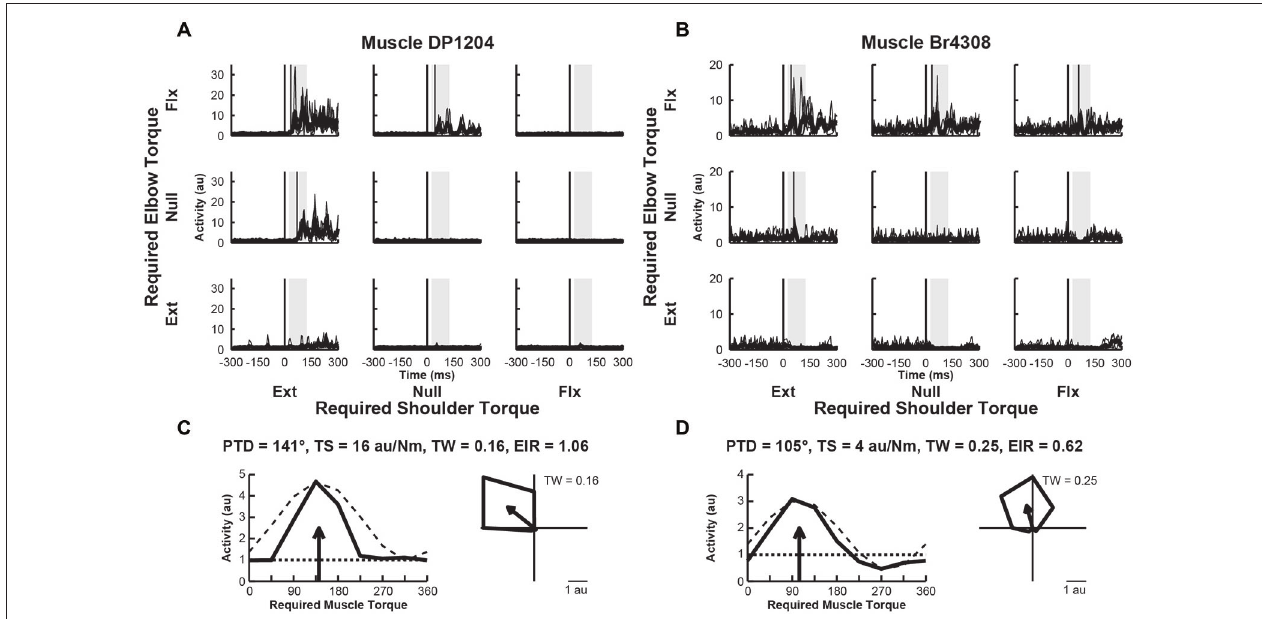
tuning of the corresponding muscle samples. Left sub-panels illustrate linear plots of overall activity vs. joint-torque angle. Unloaded baseline activities and cosine fits are shown as dotted and dashed lines, respectively. Right sub-panels show polar plots of the perturbation-related activity (baseline removed) in joint-torque space. PTD, preferred-torque direction; TS, torque-slope; TW, tuning width; EIR, excitation-inhibition